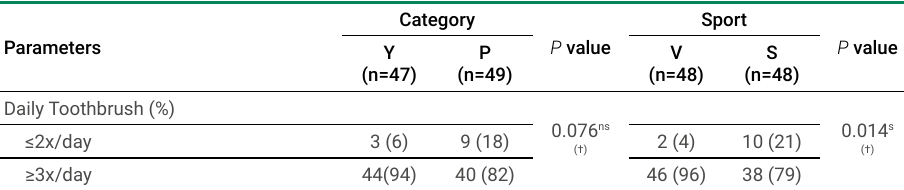
Table 2. Frequency of toothbrushing and oral health conditions category: youth (Y) and professional (P) athletes, and sport: volleyball (V) and soccer (S). (Ponta Grossa, Paraná, Brazil, 2018 to 2020).